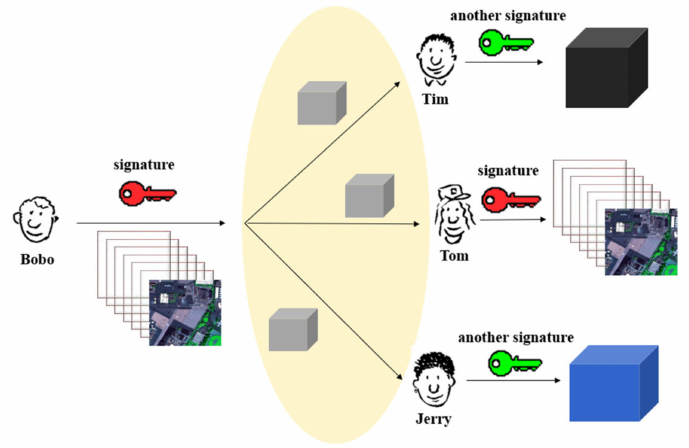
Figure 4. Flowchart of signature